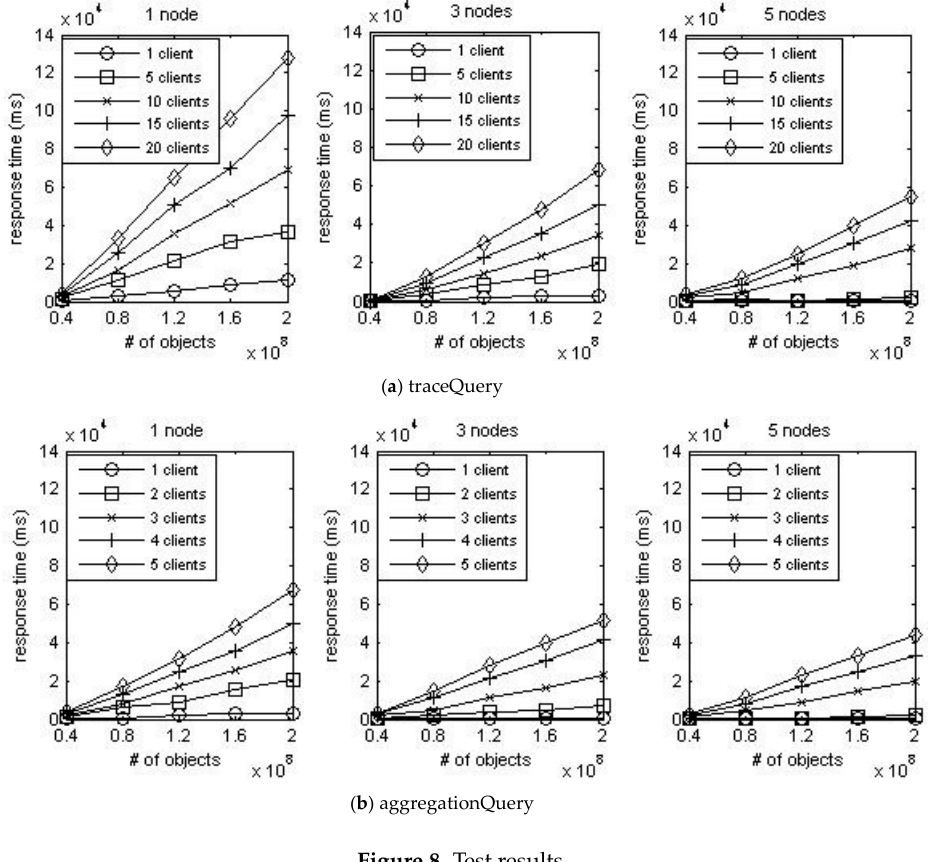
Figure 8. Test results.